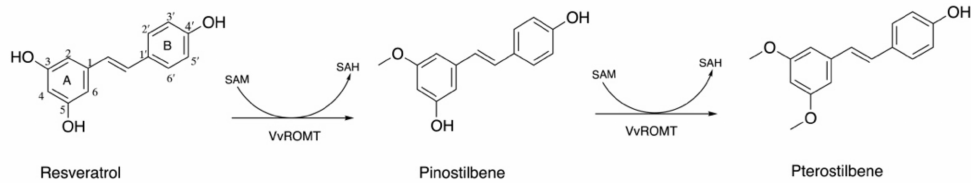
Scheme 1. Representation of the VvROMT sequential di-methylation reaction. VvROMT